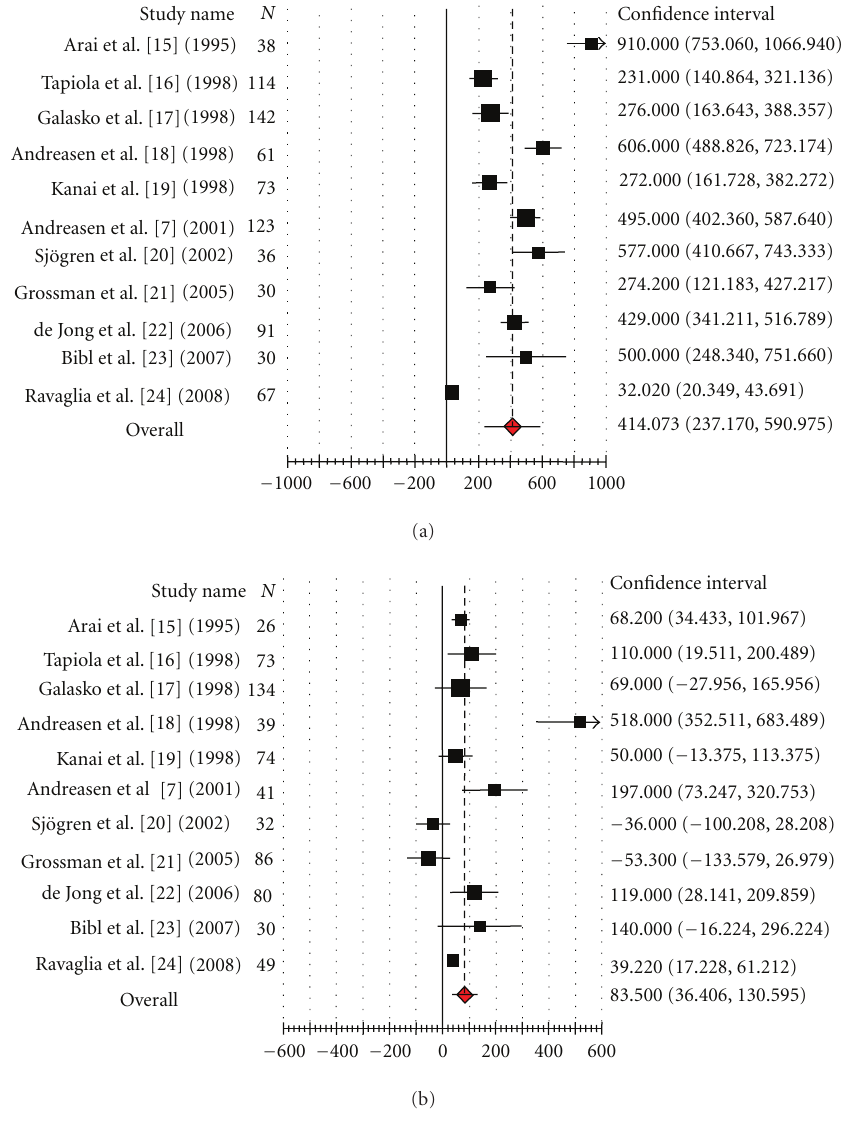
Figure 1: (a) CSF tau level in Alzheimer’s disease. (b) CSF tau level in dementia due to other